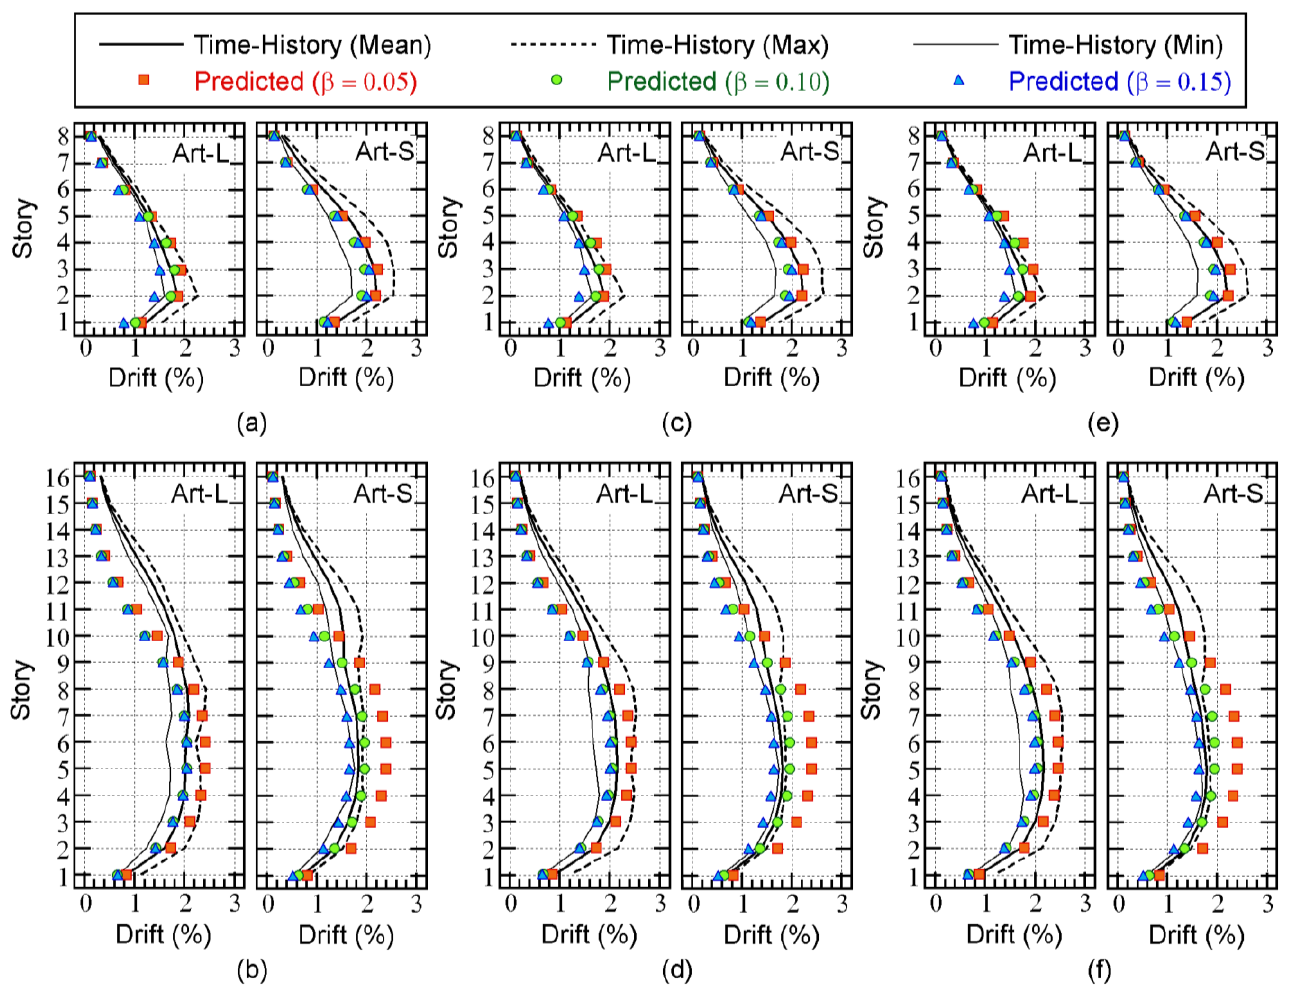
Figure 12. Comparisons of the peak story drift: ( a ) 8-story model (